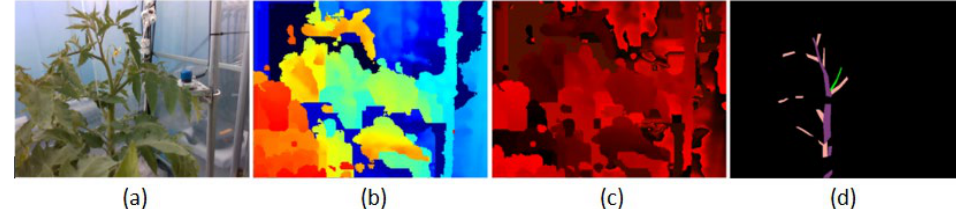
Figure 4. Four types of images in our dataset. ( a ) is RGB image, ( b ) is colored depth image, ( c ) is encoded depth image, and ( d ) is labeled image.